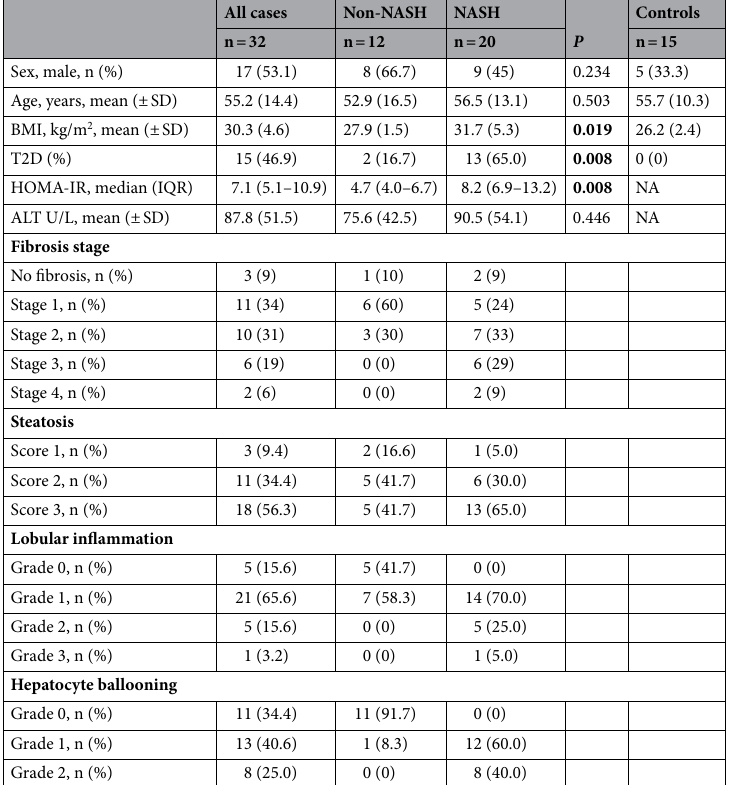
Table 1. Cohort characteristics. BMI, Body Mass Index; T2D, Type 2 Diabetes; HOMA-IR, Homeostatic Model Assessment for Insulin Resistance; ALT, Alanine aminotransferase; NASH, Nonalcoholic Steatohepatitis; NA, data not available. Values in bold denotes significance at the level of p < 0.05. P denotes difference between the subgroups non-NASH and